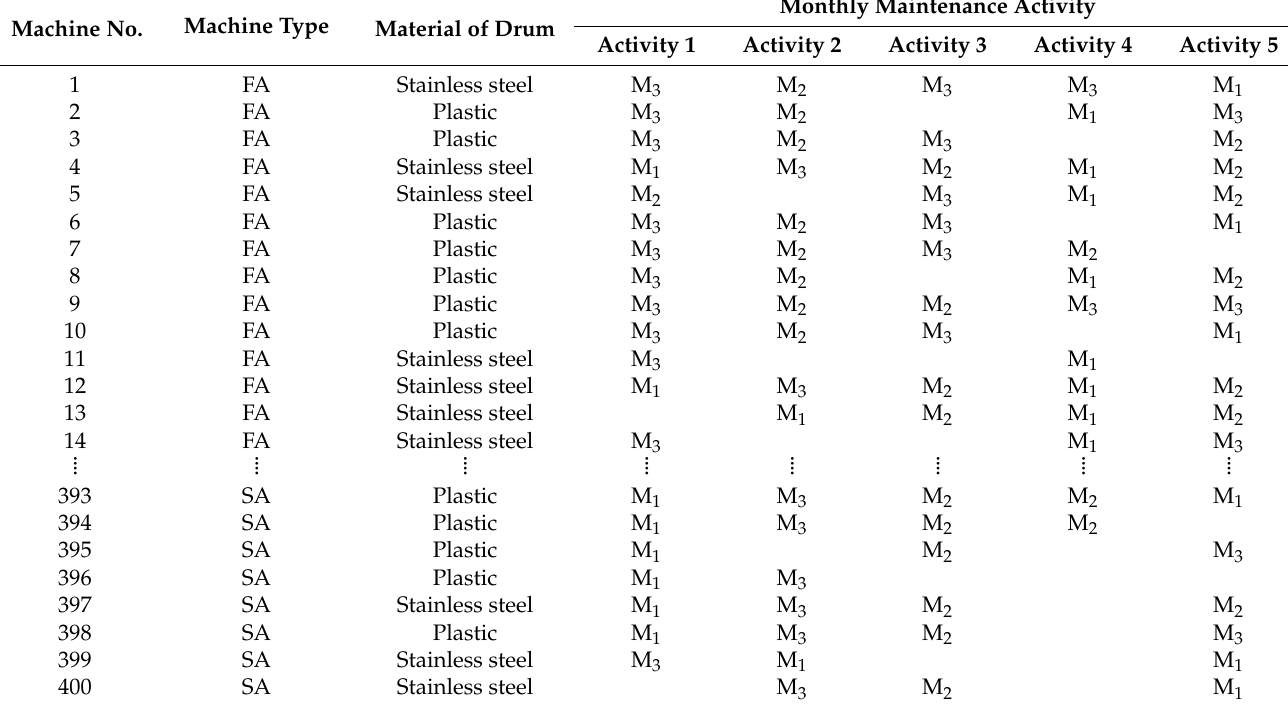
Table 10. Testing data for washing machine.